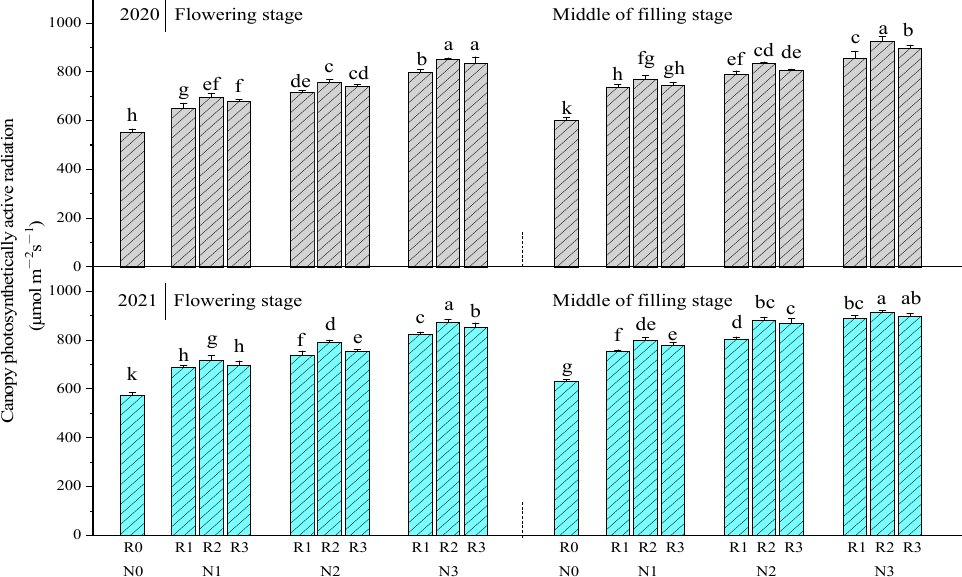
Figure 2. The effects of nitrogen application method on canopy photosynthetically active radiation. Values were means ± SD. Different letters above columns indicated significant difference within the same year under the treatments of four nitrogen levels and four ratios of basal to topdressing by LSD test (ANOVA) at the 5% level. Four nitrogen fertilization levels: N0, 0 kg ha − 1 ; N1, 120 kg ha − 1 ; N2, 180 kg ha − 1 ; N3, 240 kg ha − 1 . Four ratios of basal N to topdressing: R0, 0:0; R1, 7:3; R2, 6:4; R3, 5:5.